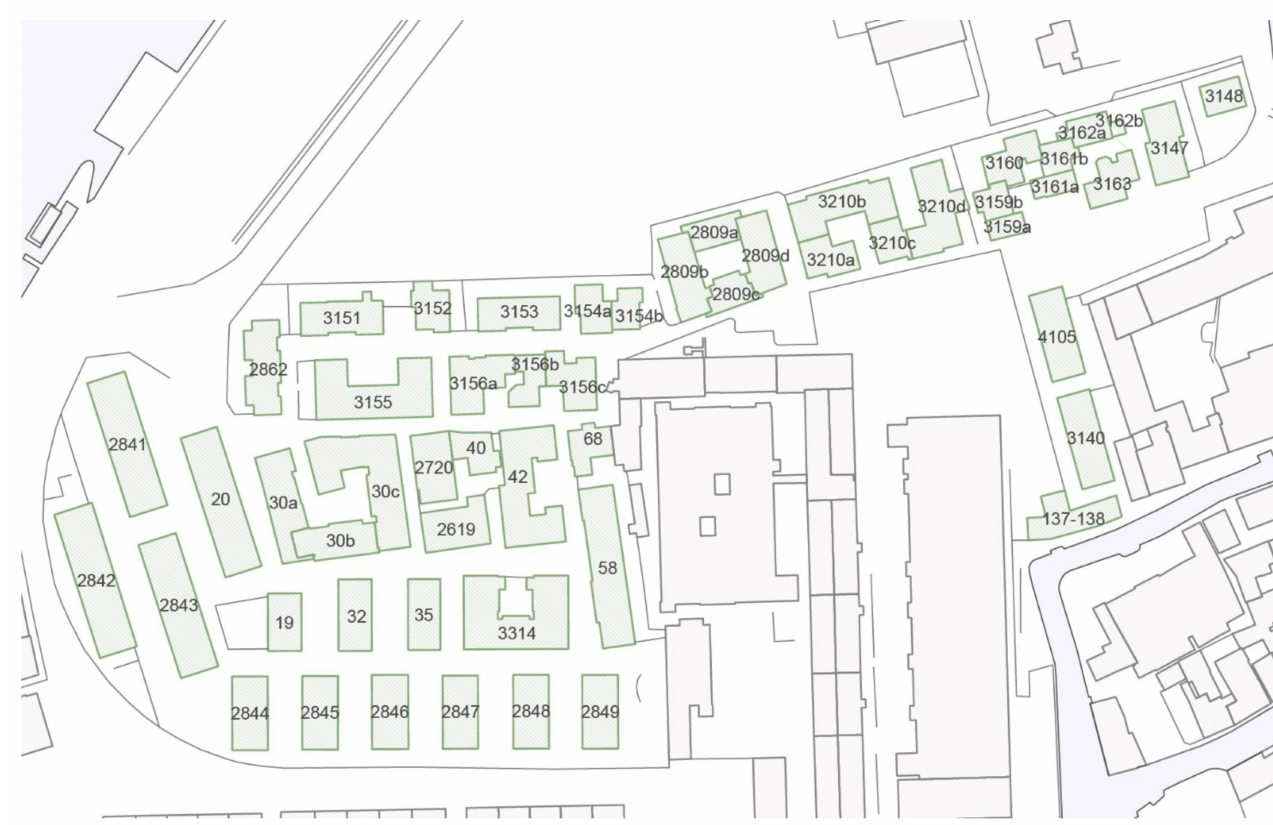
Figure 3. Subdivision and nomenclature of the